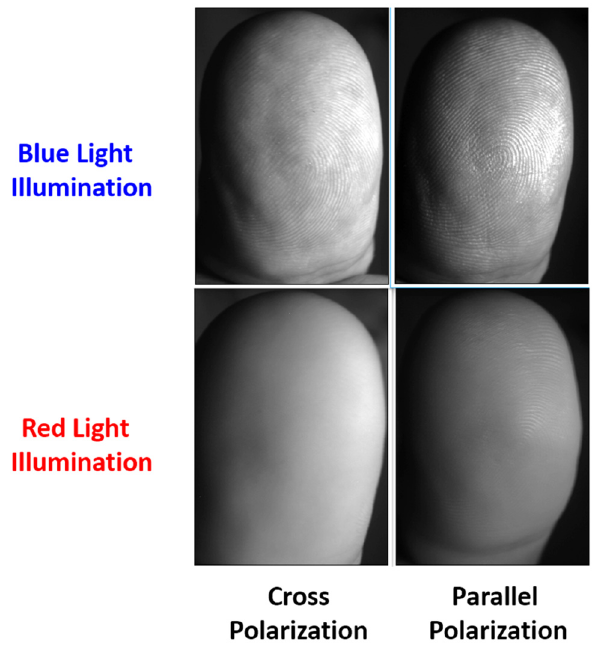
Figure 7. Effect of color and polarization on surface